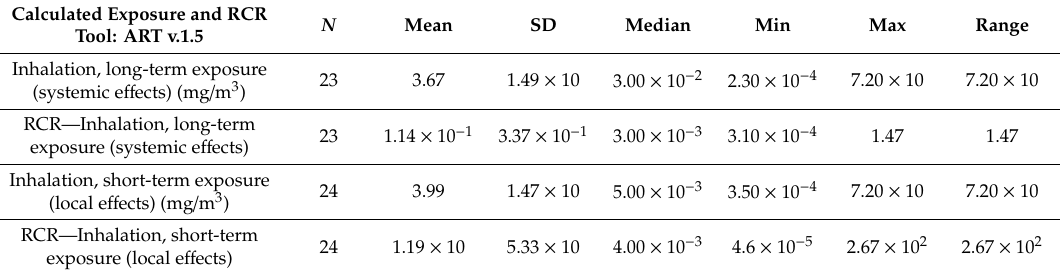
Table 8. Number of valid (N) exposure estimates calculated with ART v.1.5 model and associated RCRs for each route of exposure evaluated. SD: standard deviation; Min: minimum; Max: maximum. Calculated Exposure and RCR Tool: ART